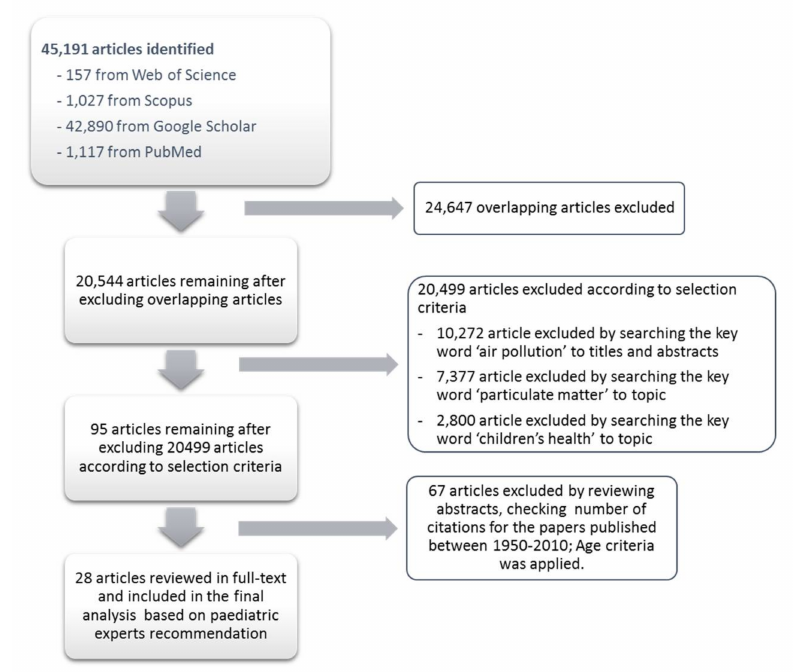
Figure 1. Selection process for articles’ review and